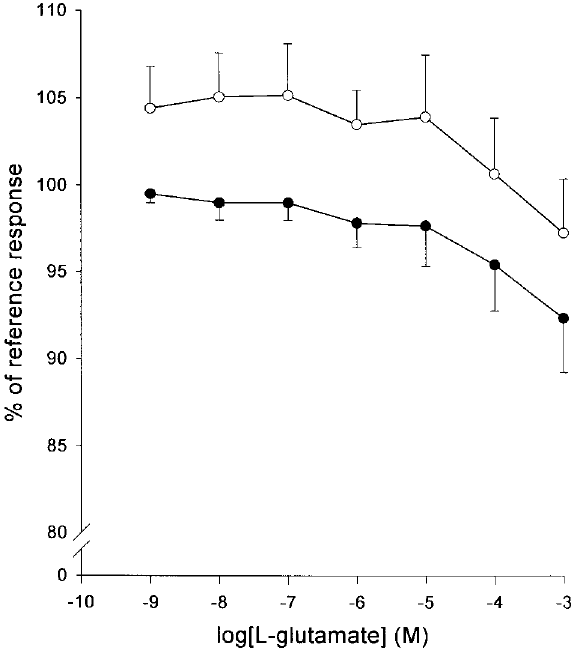
FIG. 2. L -Glutamate effect on ACh-induced contractions ( d ), and in the presence of methylene blue ( s ). The responses are mean ±SE ( n = 6) and are plotted as a percentage of the reference response before the exposure to L